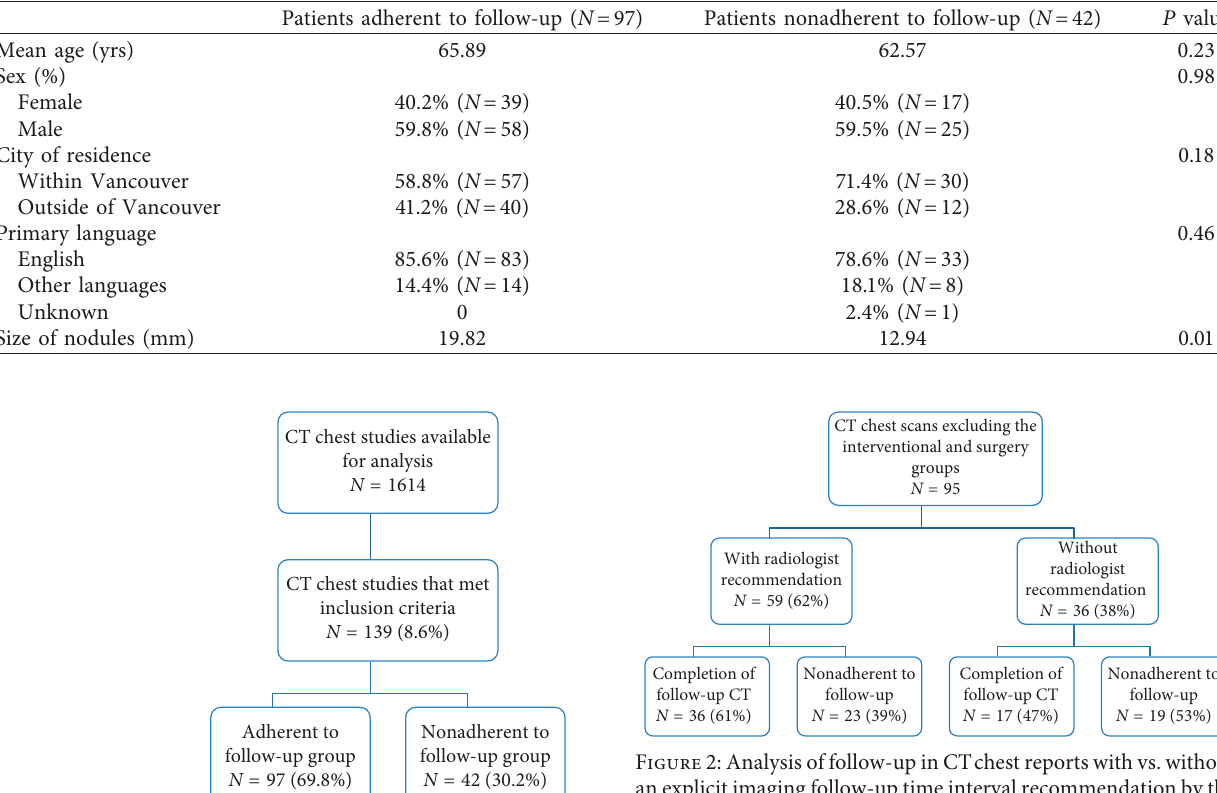
Table 1: Baseline patient characteristics of study population ( n � 139) in the adherent to follow-up vs. nonadherent to the follow-up group.